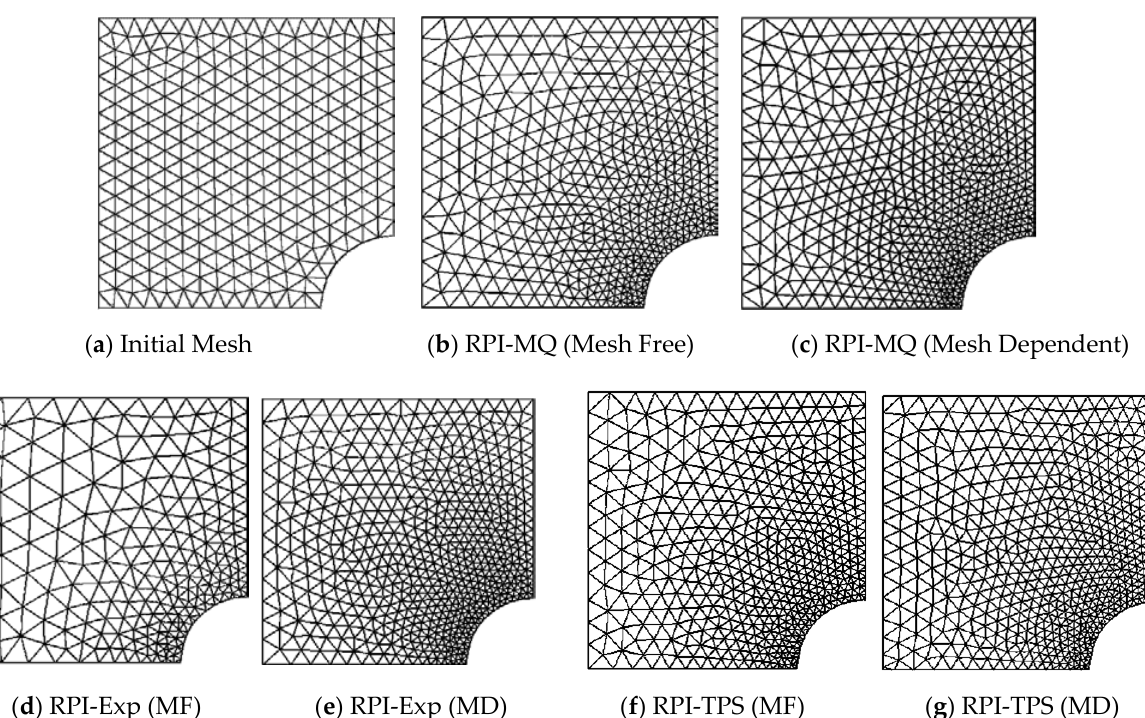
Figure 7. Adaptively improved mesh in elastic plate with opening using meshfree (MF) RPI, mesh dependent (MD) RPI having different radial basis function (initial triangular mesh elements = 548, 2% target error).